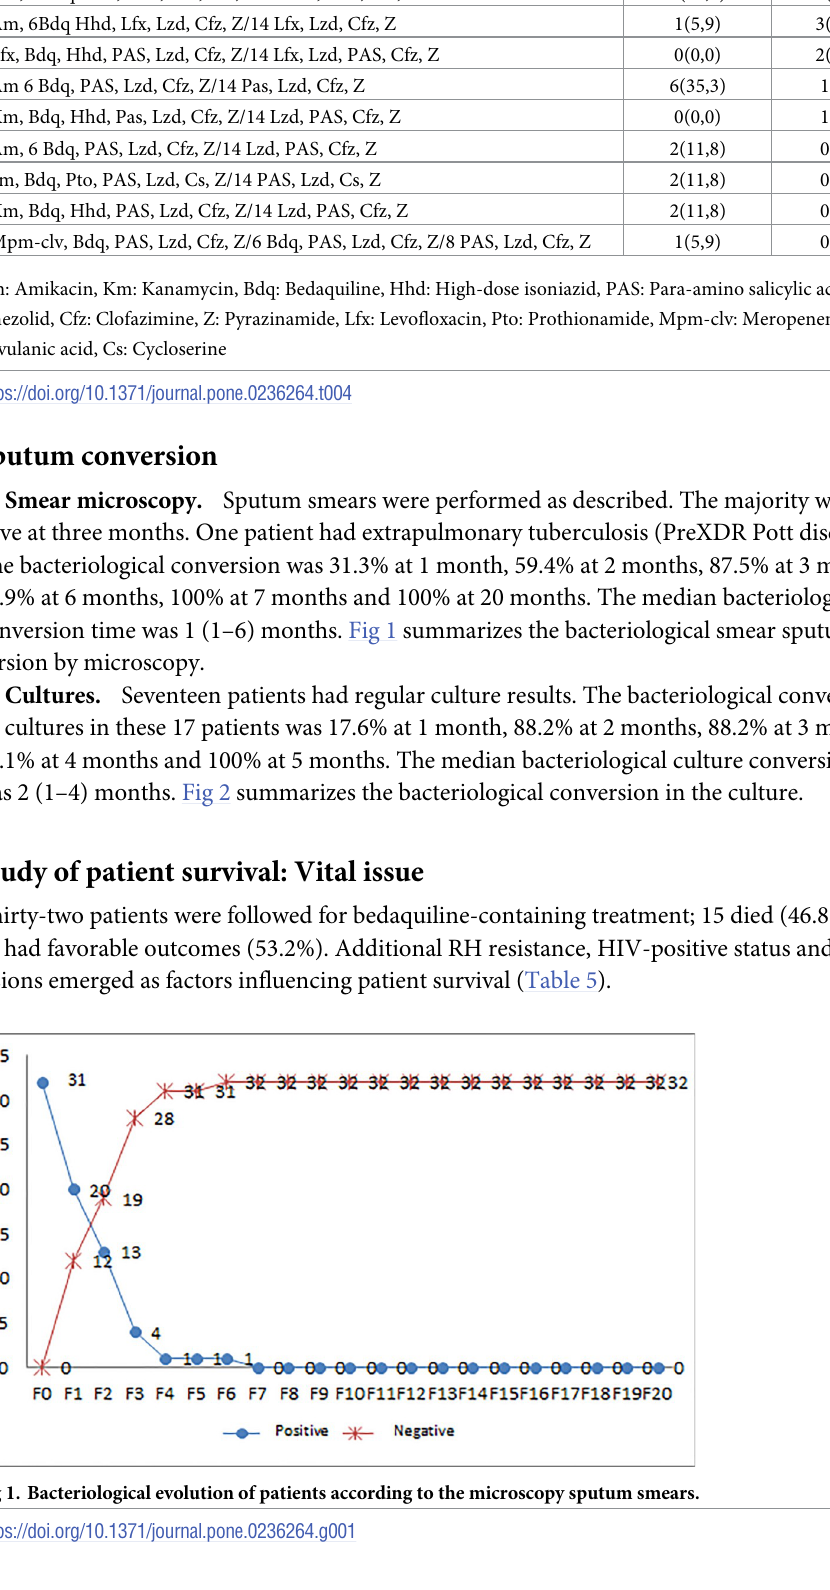
Table 4. Bedaquiline-containing treatments according to the outcomes. DR treatment used